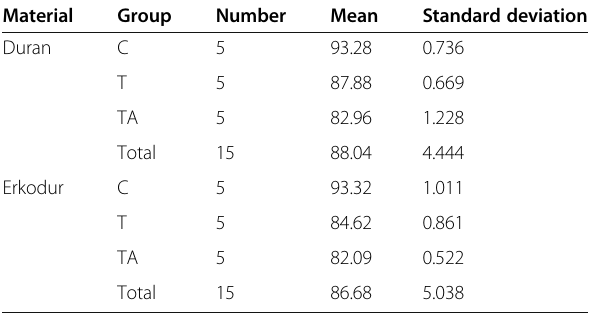
Table 4 Descriptive analysis of dynamic Tg in terms of degrees Celsius